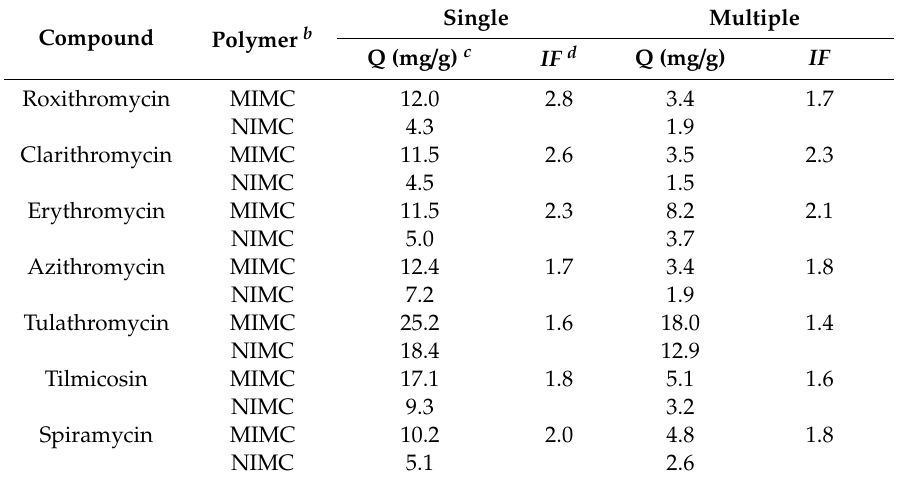
Table 1. Specific adsorption capacities of MIMC and NIMC for single and multiple macrolides a . Single Multiple Compound Polymer b Q (mg / g) c IF d Q (mg / g) IF